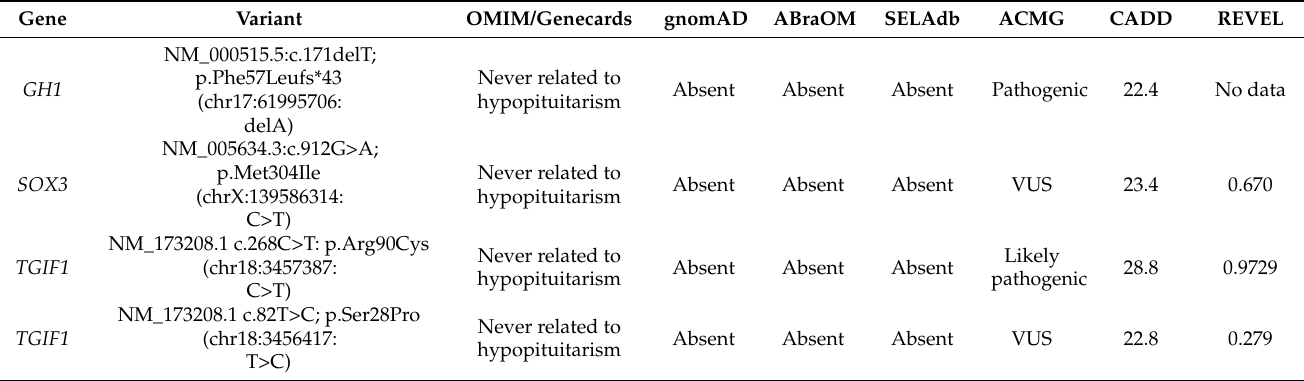
Table 3. Allelic variant classification according to